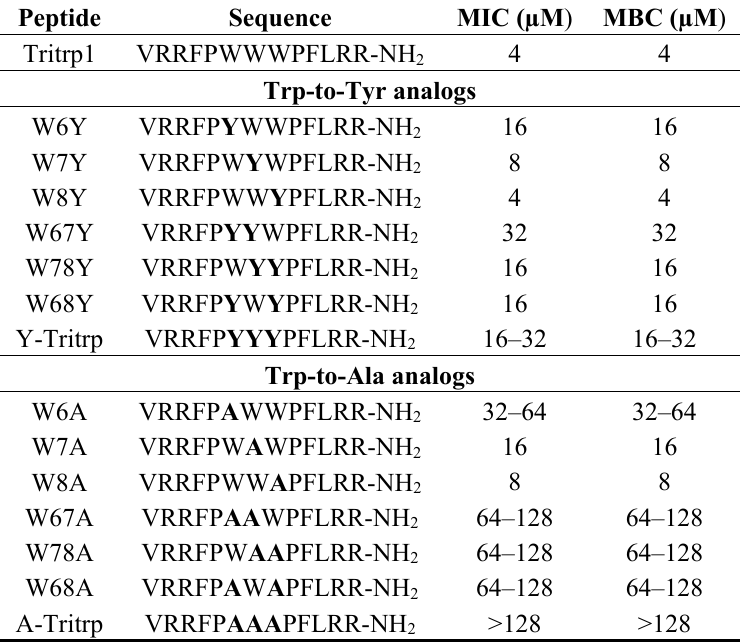
Table 1. The amino acid sequences and antimicrobial activities reported as minimal inhibitory (MIC) and bactericidal concentrations (MBC) for Tritrp1 and its analogs against E. coli ATCC